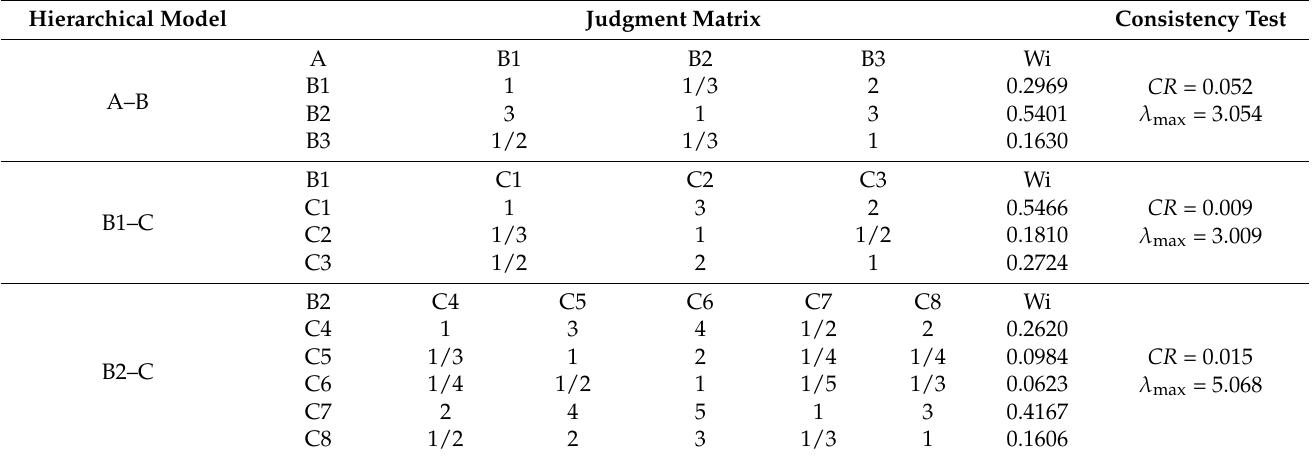
Table 2. Judgment matrix of different levels. Hierarchical Model Judgment Matrix Consistency